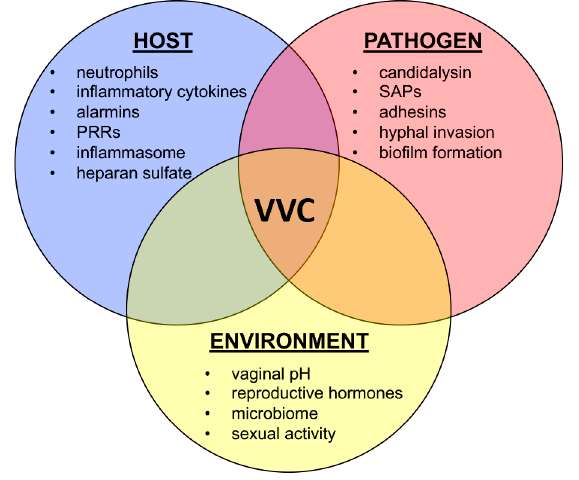
Figure 2. Vulvovaginal candidiasis (VVC) is a multifactorial disease. Multiple inputs from host (blue), pathogen (red), and environment (yellow) are required to drive disease onset and symptomatic infection. Each circle represents major contributing factors to the immunopathogenesis of VVC.